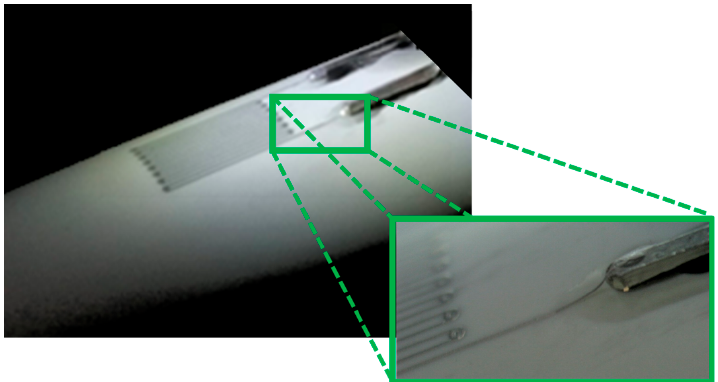
Figure 4. Strain gauge printed on a PVC conduit of 20 mm external diameter. The two ends of the printed serpentine are deposited on the right angle pin header connector.